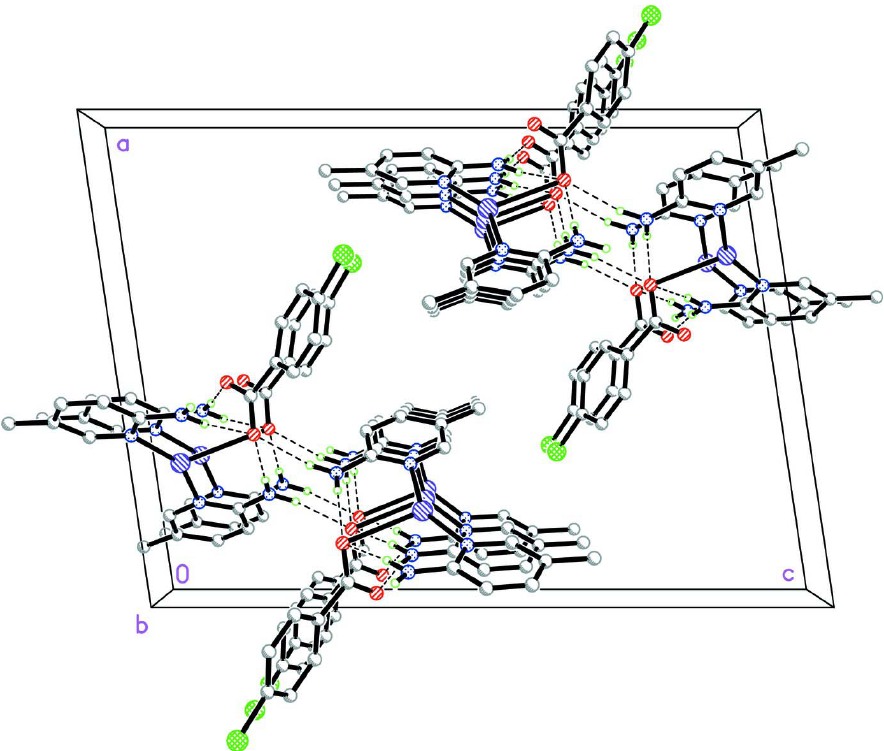
Figure 2 The crystal packing of the title compound, viewed down the b axis. Intermolecular hydrogen bonds are shown as dashed